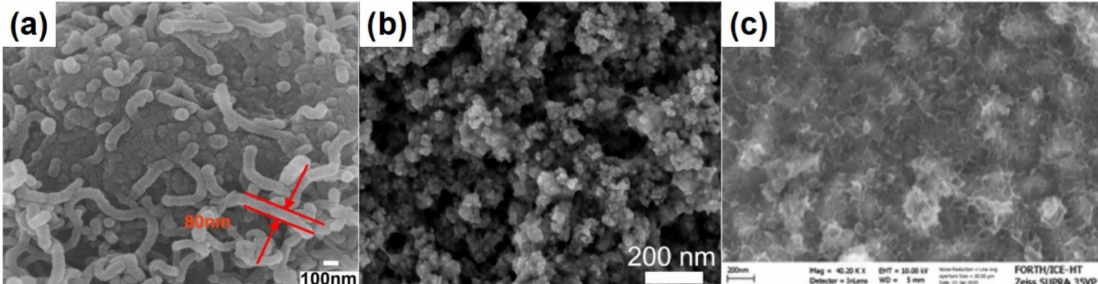
FESEM images of different hybrids counter electrodes based on conductive